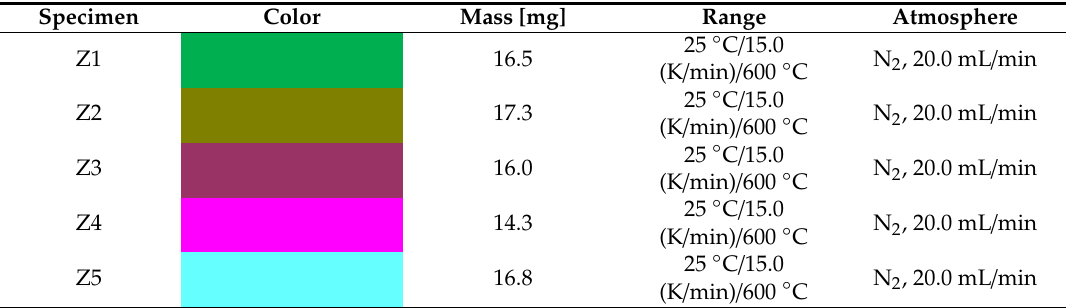
Table 7. Parameters of di ff erential scanning calorimetry (DSC)